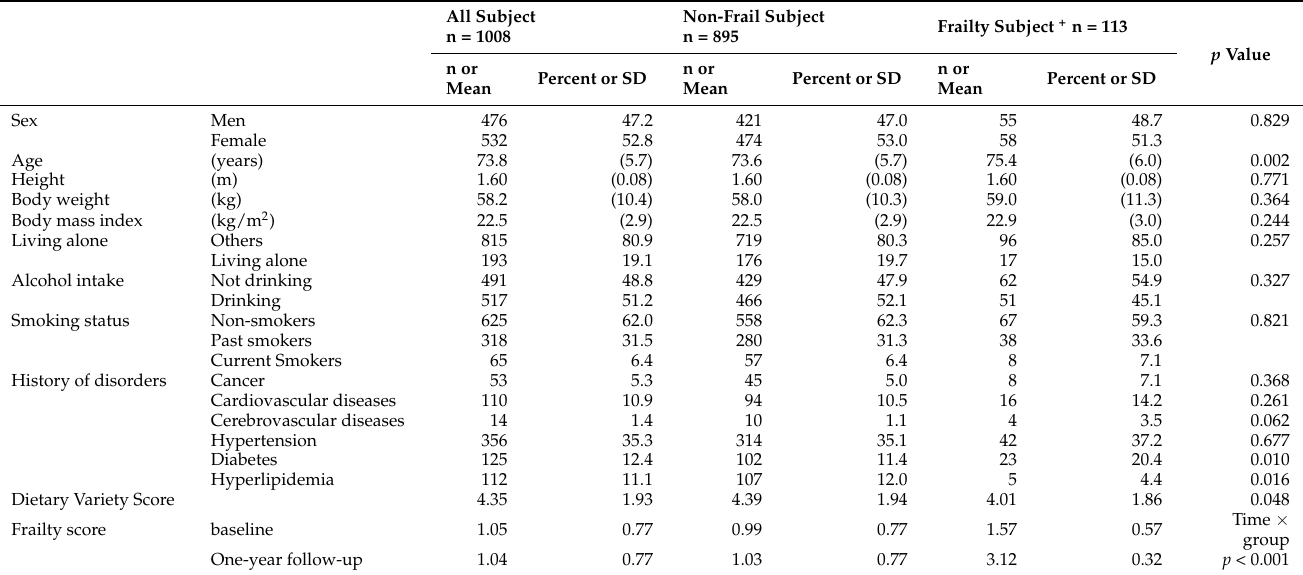
Table 1. Baseline